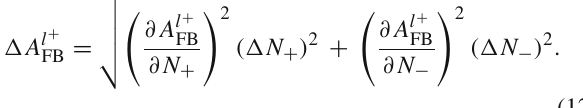
Fig. 4 ComparisonbetweensignalandbackgroundfordifferentMajo- rana neutrino masses, cut in missing E T and the transversal momentum of the final lepton p T , l + . The arrows indicate the cuts and backgrounds used in the analysis